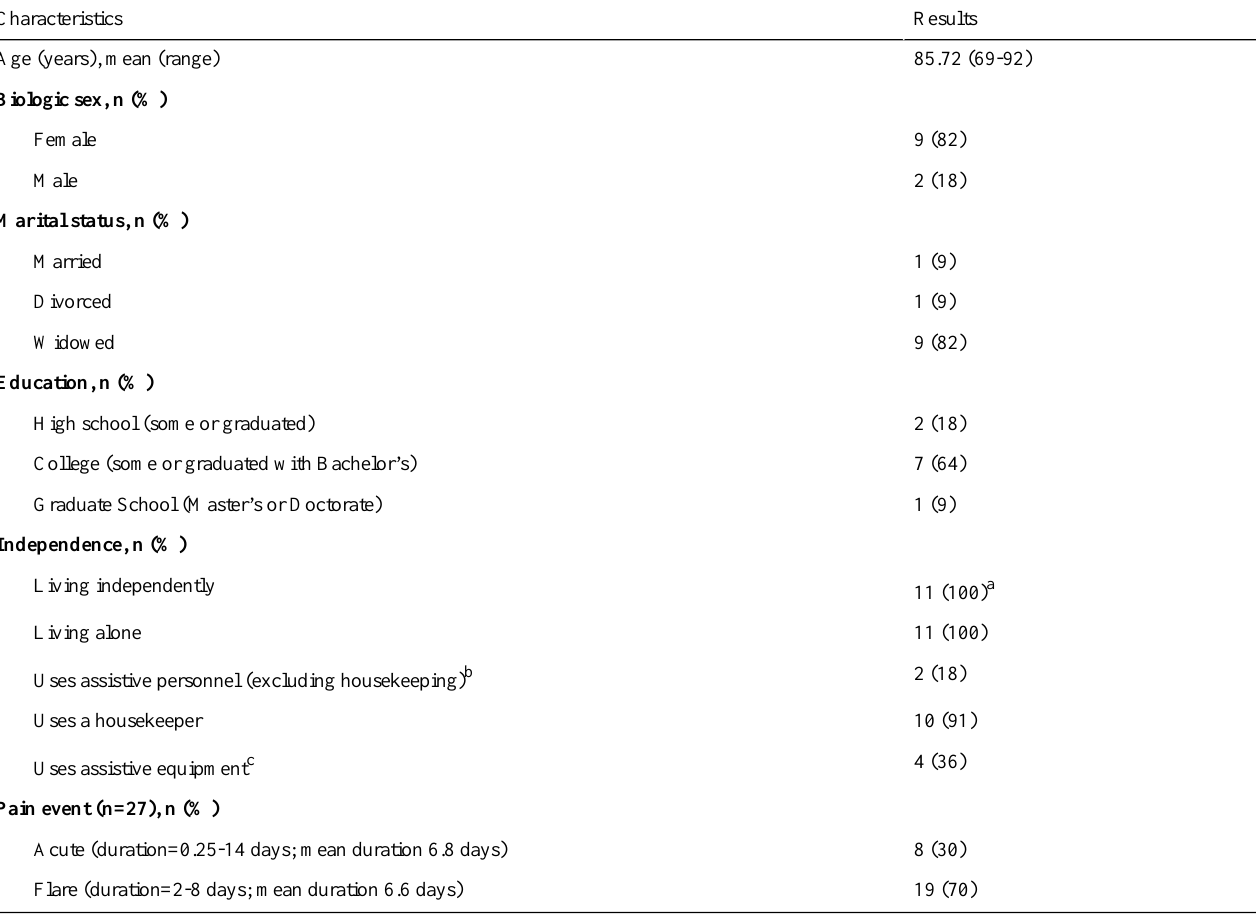
Table 1. Demographic characteristics of the study sample (N=11).